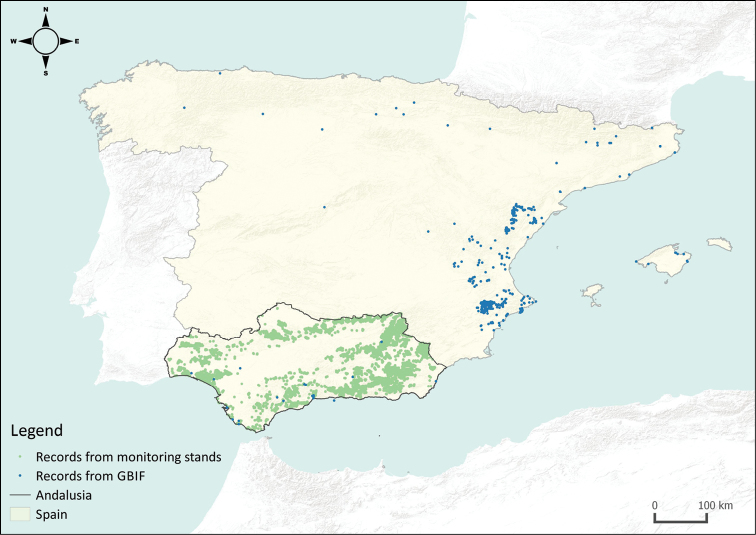
Distribution of Thaumetopoeapityocampa records from GBIF in Spain and records provided in this dataset. Records from GBIF were downloaded on 2018-03-16 using the R package “rgbif” (Chamberlain et al. 2016).